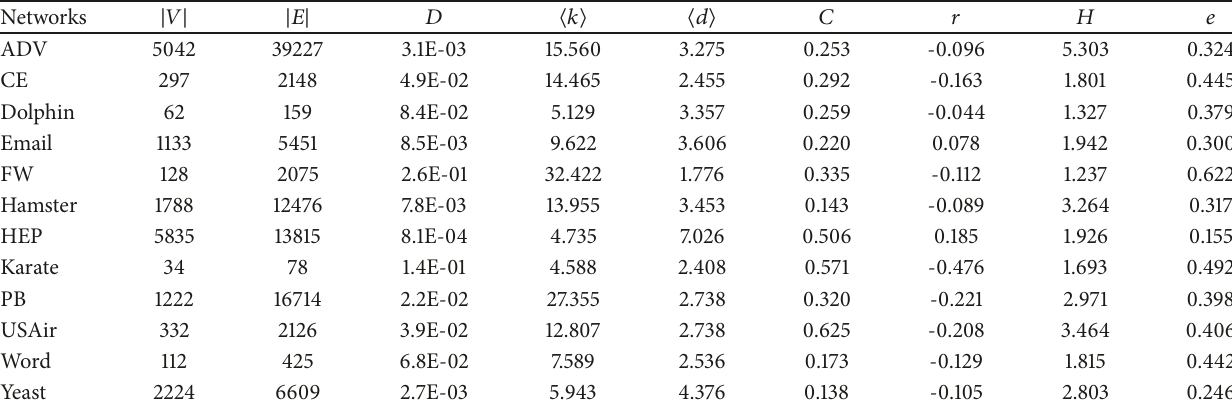
Table 1: The basic structural features of the giant components of the 12 networks. |𝑉| and |𝐸| are the total numbers of nodes and edges, respectively. 𝐷 denotes the density, which is 𝐷 = 2|𝐸|/|𝑉|(|𝑉| − 1) . ⟨𝑘⟩ and ⟨𝑑⟩ present the average degree and the average shortest distance, respectively. 𝐶 and 𝑟 indicate the clustering coefficient [26] and assortative coefficient [36], respectively. 𝐻 is the degree heterogeneity [6],